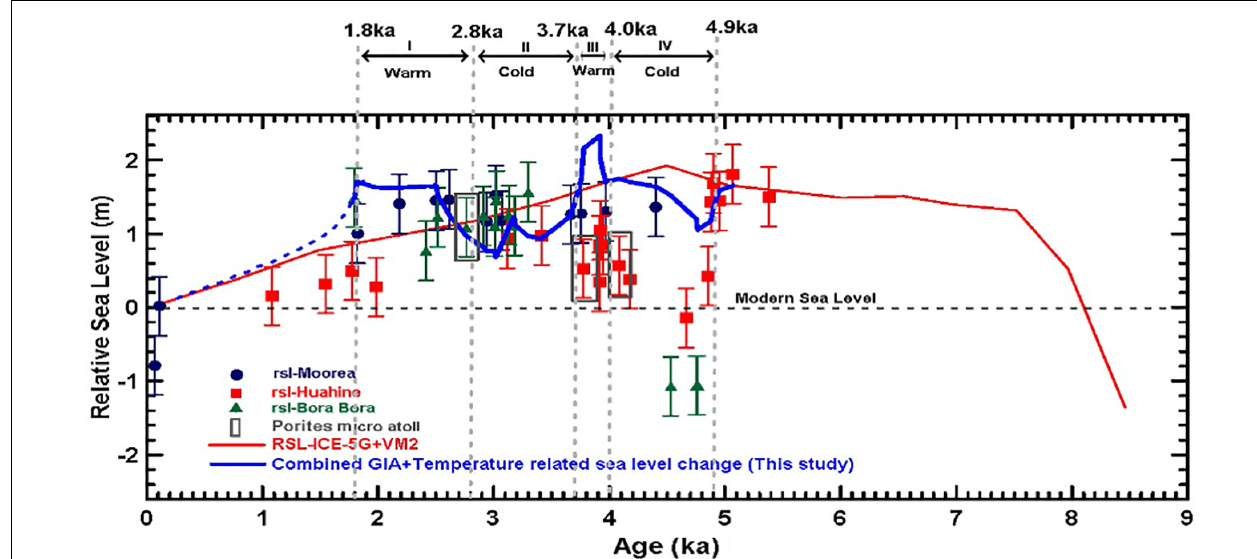
FIGURE 10 | Sea level-temperature relationships in the Pacific during the Holocene. Sea level estimates are from previously published study (Rashid et al., 2014) using empirical data and GIA model. Red curve represents the GIA model prediction of mean sea level curve for the Society Islands from Mid to Late Holocene. Individual data points represent sea level data obtained from coral samples from Moorea (blue), Huahine (red) and Bora Bora (green). The combined GIA-temperature relationship reveals the amplitudinal sea level variations, reconciling the discrepancy between the GIA estimation and the empirical observations between 2 to 2.6 ka.